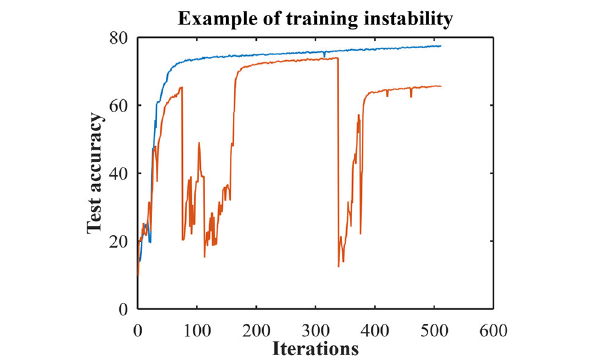
FIGURE 1 | An example of training to a poor local minimum (blue) and training with instabilities (red). Both end with poor test accuracies but for different reasons.